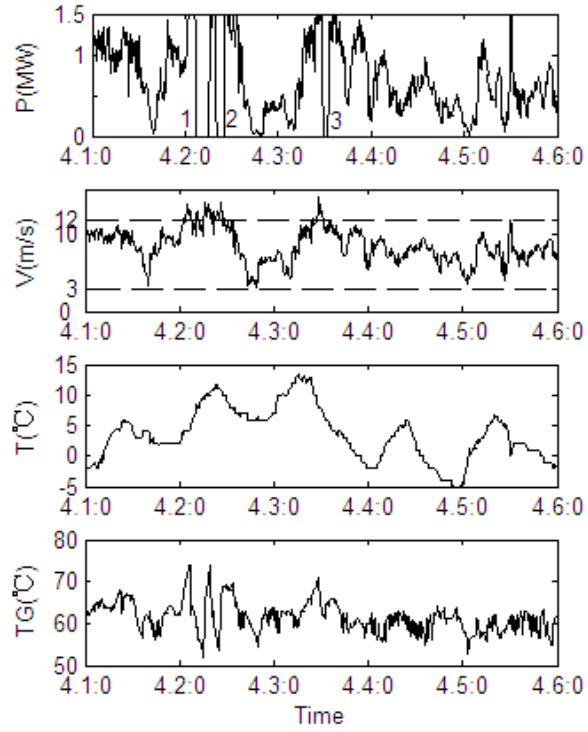
Figure 7. Trends from 01/04/2006 to